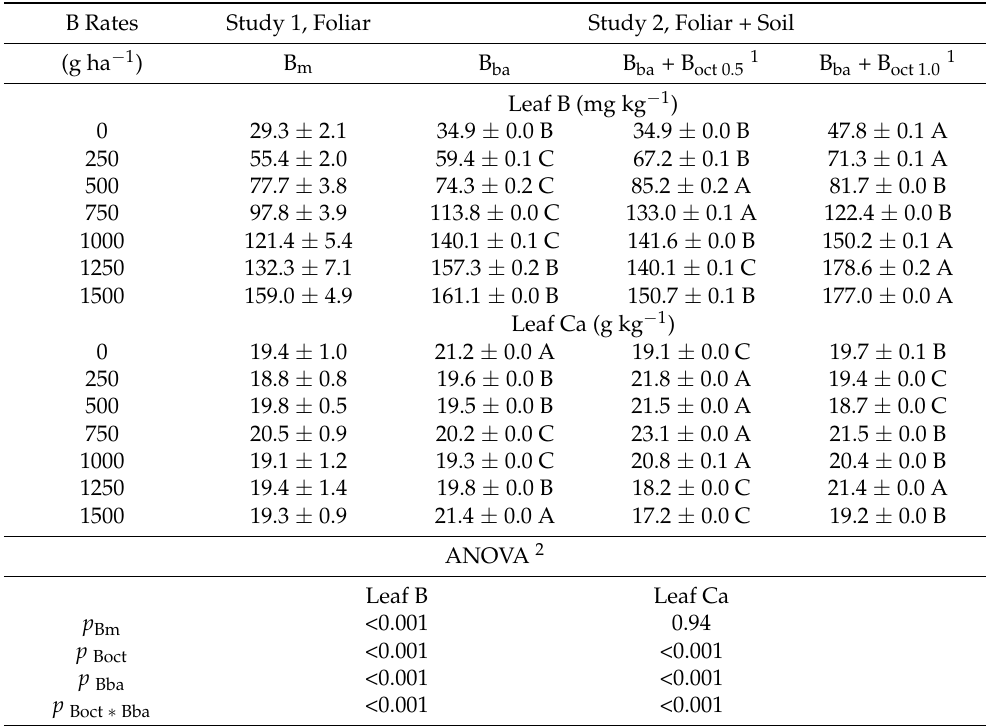
Table 3. Leaf boron (mg kg − 1 ) and calcium (g kg − 1 ) in Study 1 with foliar application of B (Bm, monoethanolamine) using six B rates (250, 500, 750, 1000, 1250 and 1500 g ha − 1 ), and in Study 2 with B application in soil using sodium octaborate (Boct) with two rates (Boct0.5: 0.5 kg ha − 1 ; and